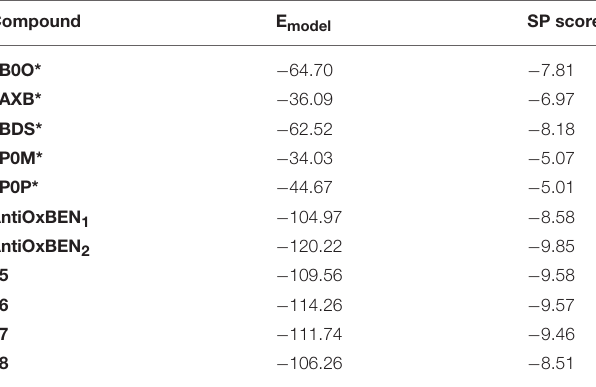
TABLE 3 | E model and SP scoring values for co-crystallized ligands and our set of derivatives.